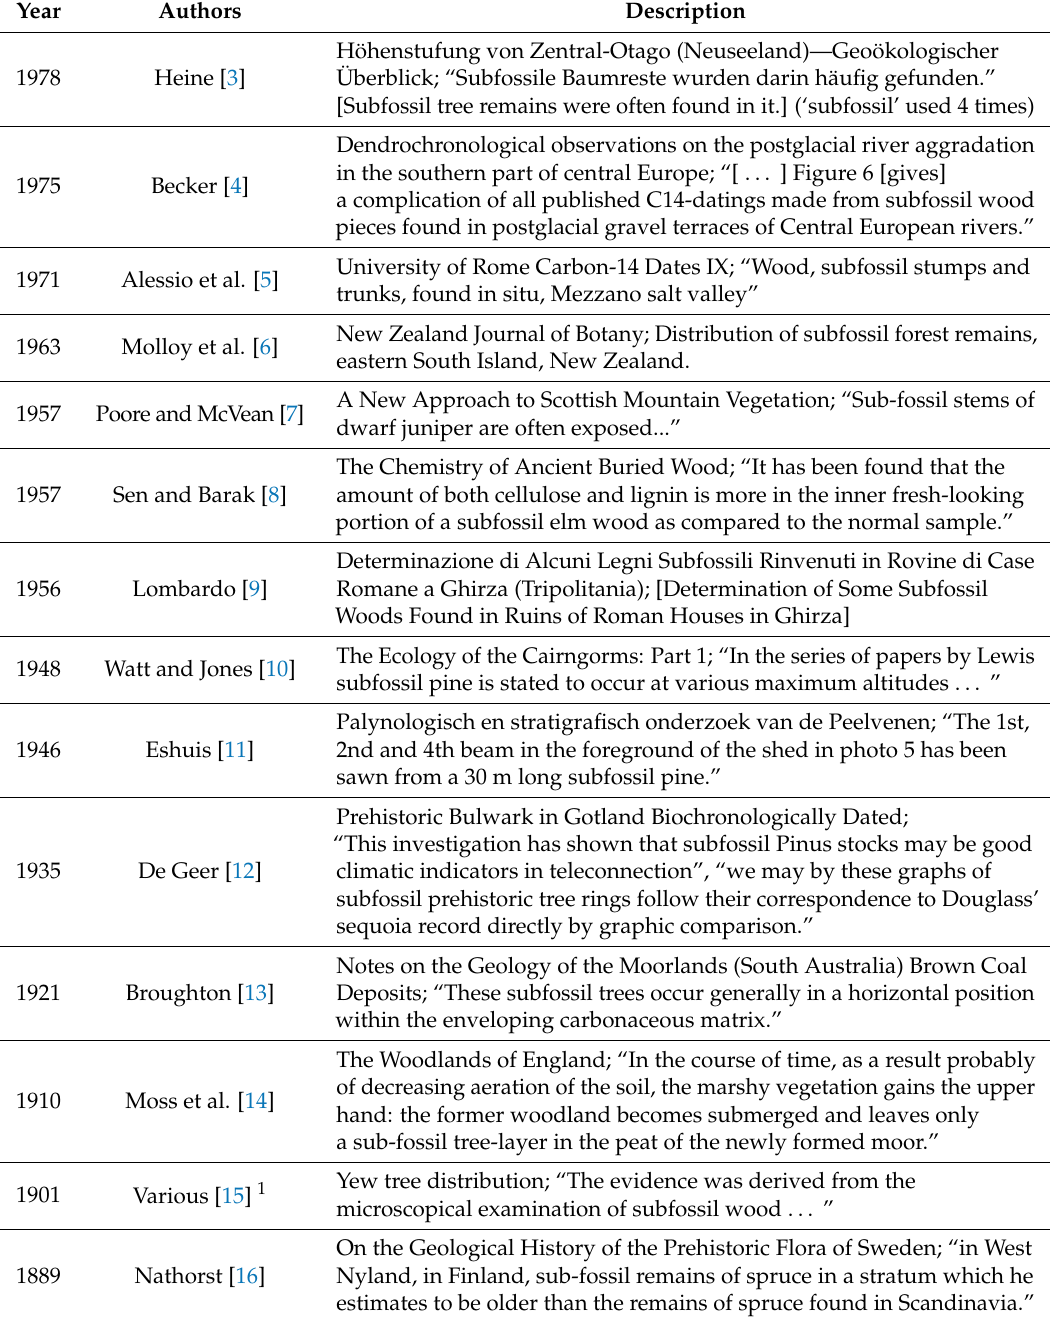
Table 1. Selected examples from among 50+ pre-1980 references that used “subfossil” in the context of preserved wood. Description includes title and excerpt in which “subfossil” was used in the text, where